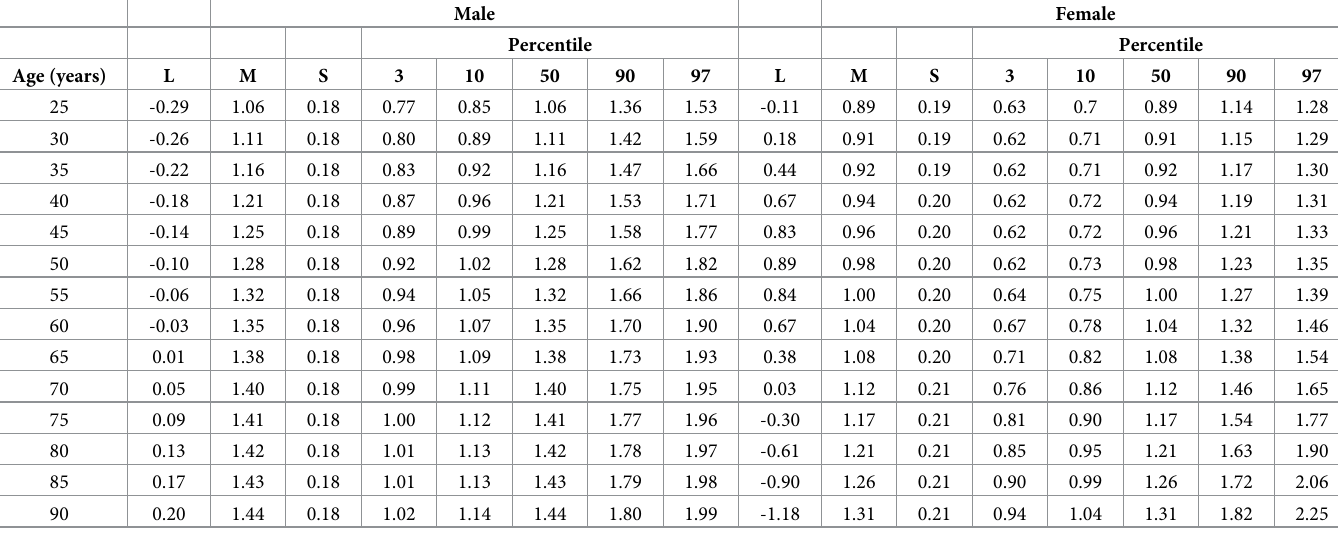
Table 6. Sex-specific percentile values for Trunk/Limb % fat ratio in individuals aged 21–90